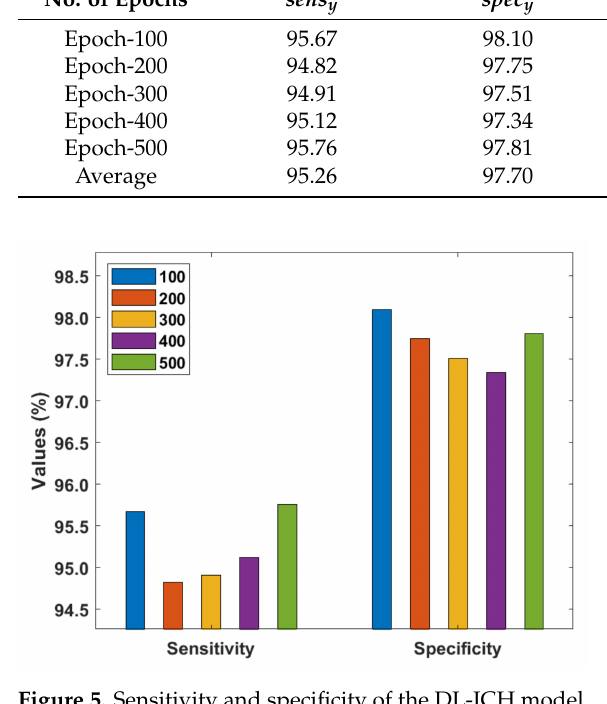
Figure 5. Sensitivity and specificity of the DL-ICH model.